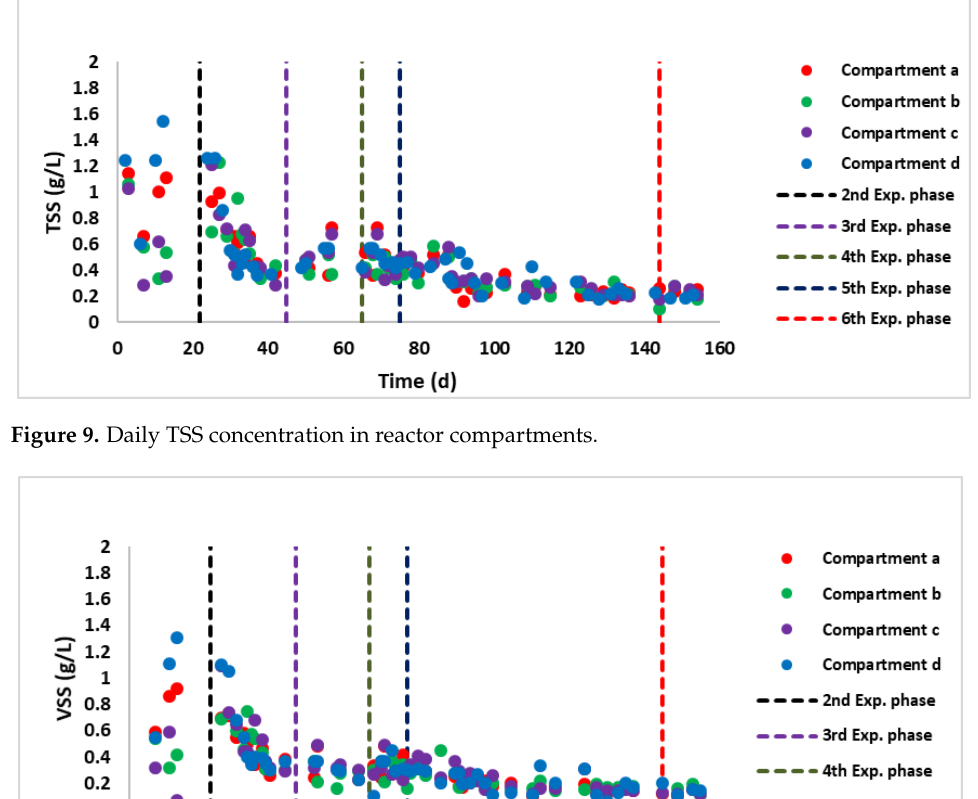
Table 5 . Average daily TSS and VSS concentration in feedstock, reactor ’ s compartments and effluent.